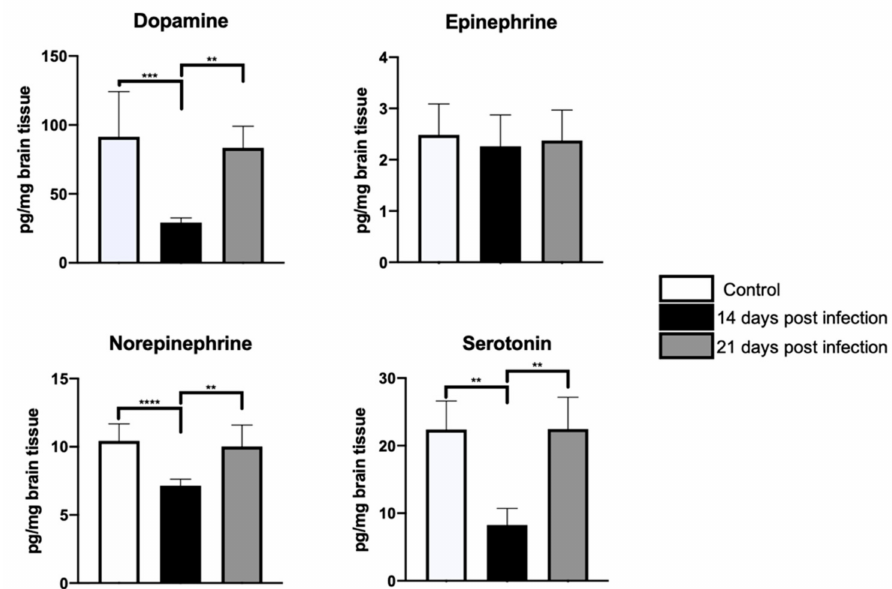
Figure 4. Neurotransmitter concentration in the hippocampus. HPLC analyses showed a transient drop at 14-PI, followed by a recovery at day 21-PI of hippocampal dopamine, norepinephrine, and serotonin levels in infected mice as compared with control mice. ANOVA tests were used in all cases, except for serotonin, in which the Kruskal–Wallis tests were utilized. Statistical significance was recognized when p < 0.05. Statistical significance is represented as follows: ** p < 0.01; *** p < 0.001; **** p <